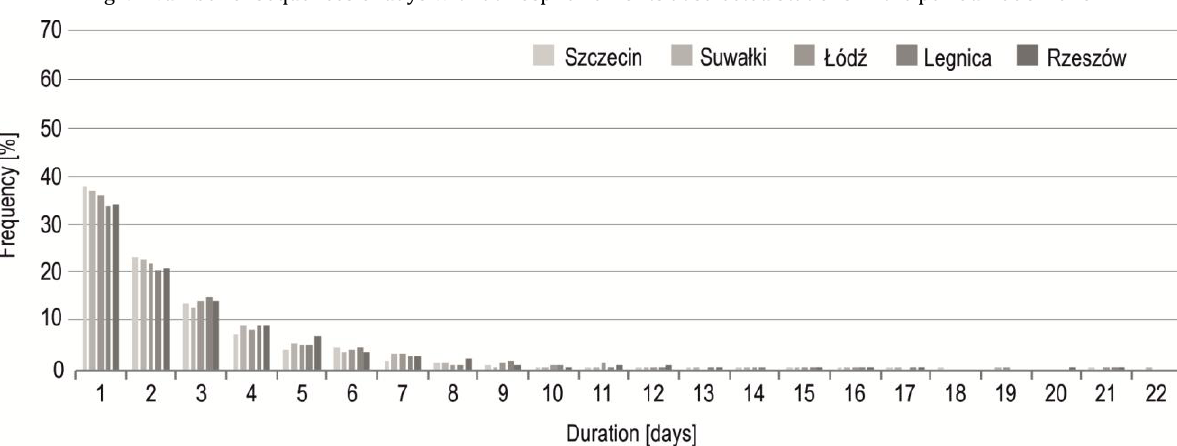
Fig. 8. Number of sequences of days without atmospheric fronts at selected stations in the period